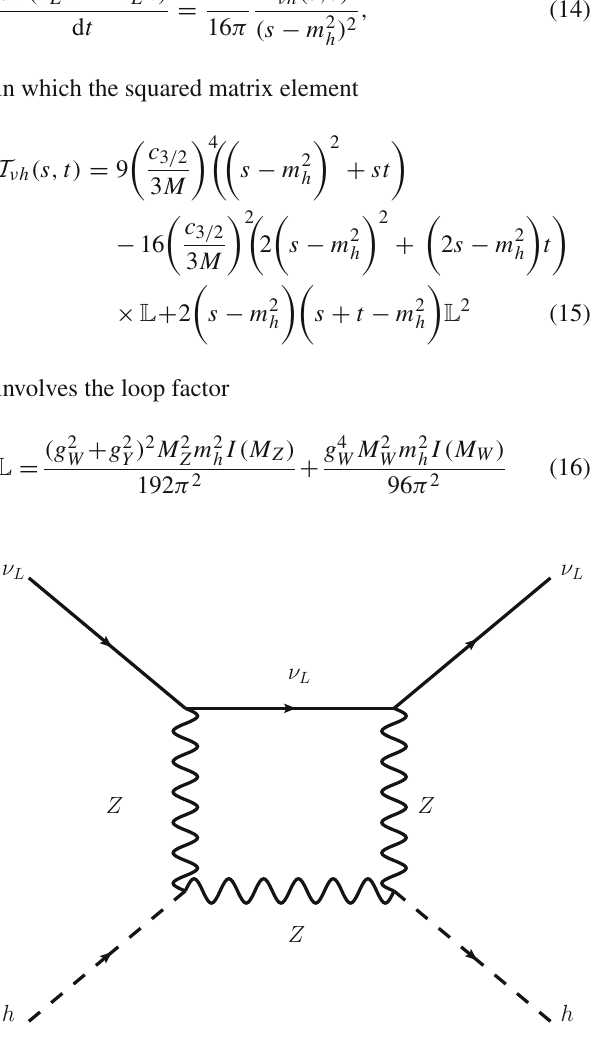
√ s for M = 1 , 2 and